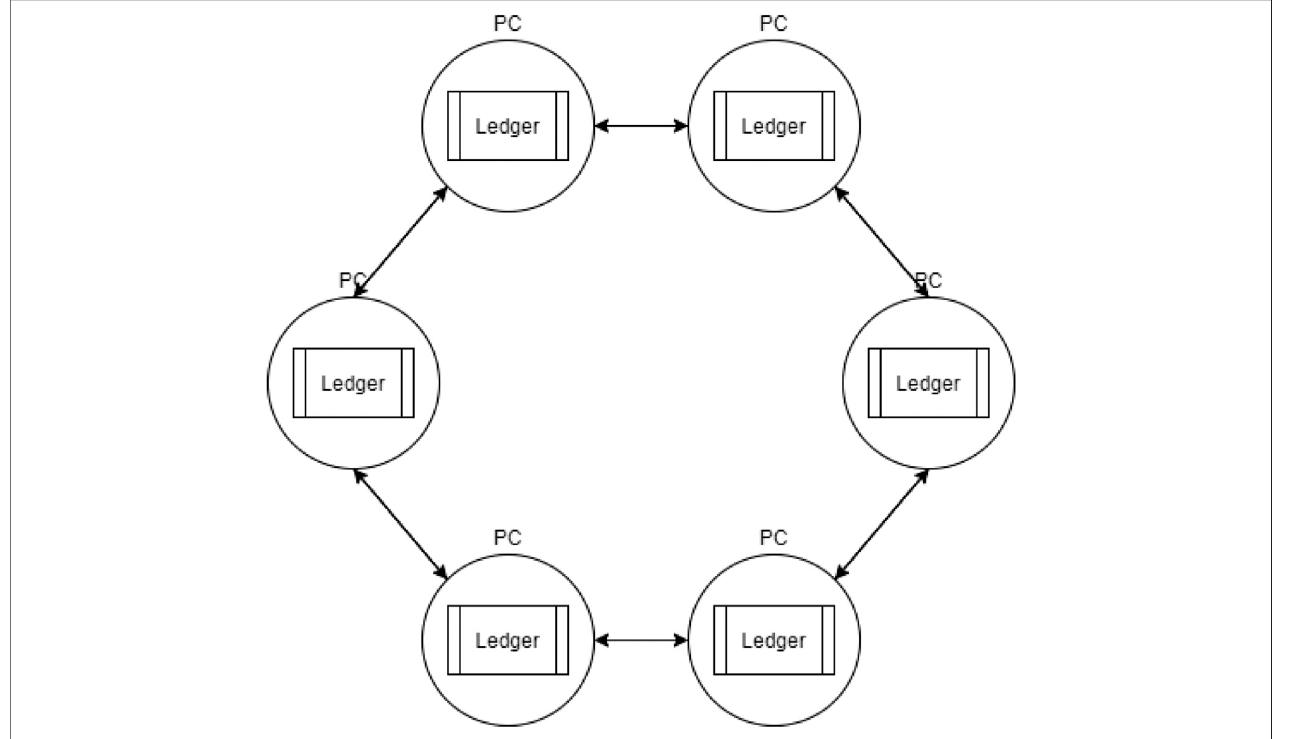
FIGURE 1 | Blockchain